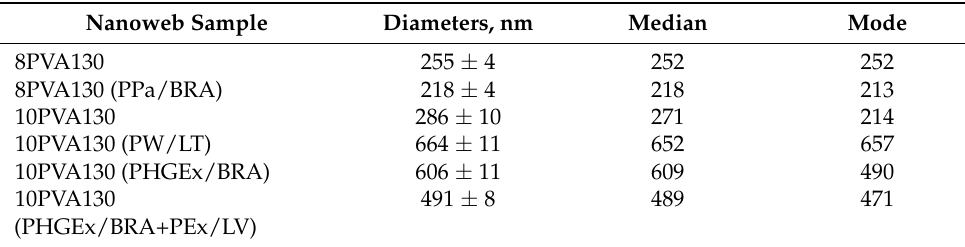
Figure 2. Micrographs of electrospun webs: ( a ) 10PVA130; ( b ) 10PVA130(PW/LT); ( c ) 10PVA130(PHGEx/BRA), ( d ) 8PVA130, ( e ) 10PVA130(PHGEx/BRA+ PEx/LV), ( f ) 8PVA130(PPa/BRA). Table 4. Fibers diameters.